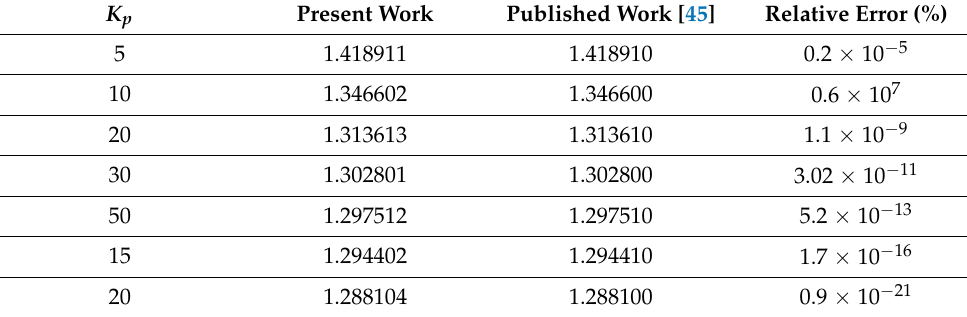
Table 2. Validation of the present work to the published work for Skin Friction (SF) 𝐶 𝑓 √𝑅𝑒 𝑠 by